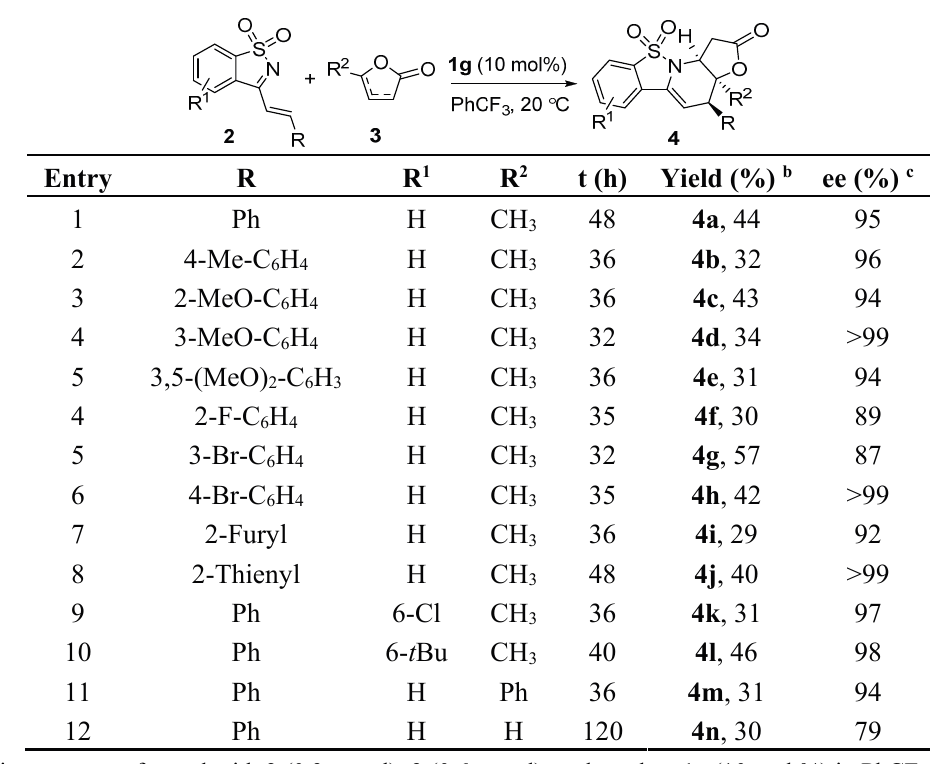
Table 3. Substrate scope of endo -cycloaddition reaction a